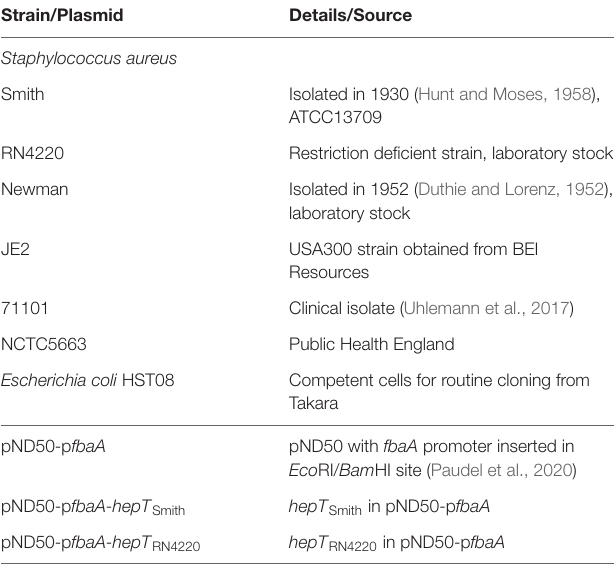
TABLE 1 | Bacterial strains and plasmids used in this study.